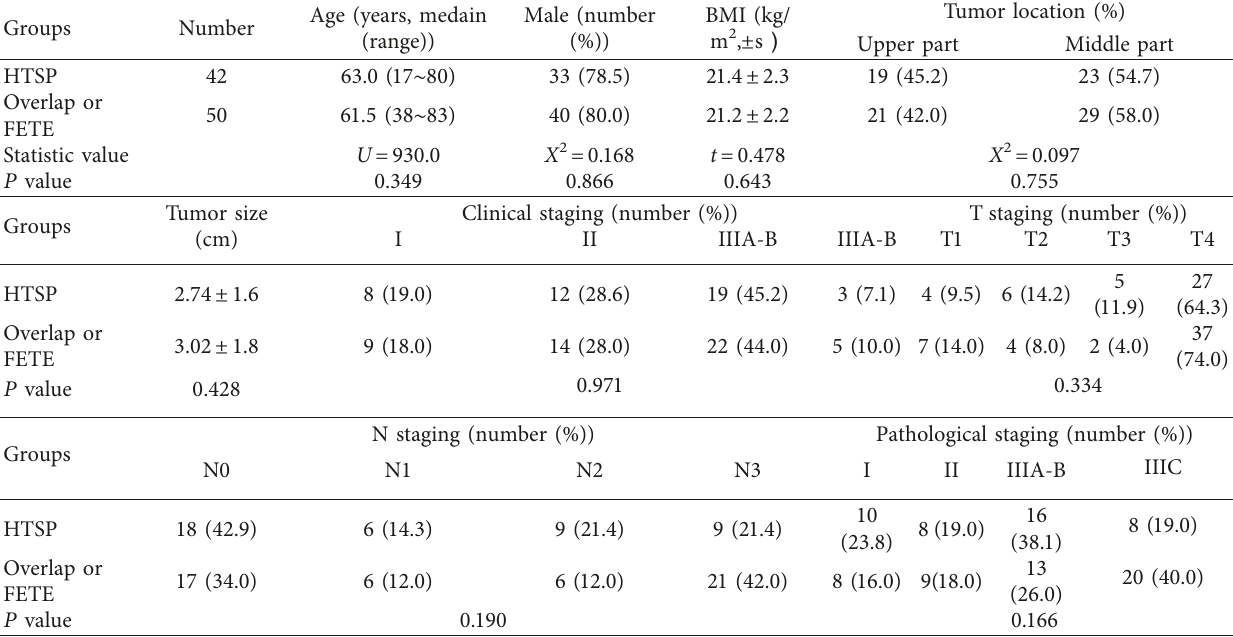
Table 1: Comparison of general data of gastric cancer patients in the half-transected and self-pulling group (HTSP group) and the traditional anastomosis group (overlap or FETE group).